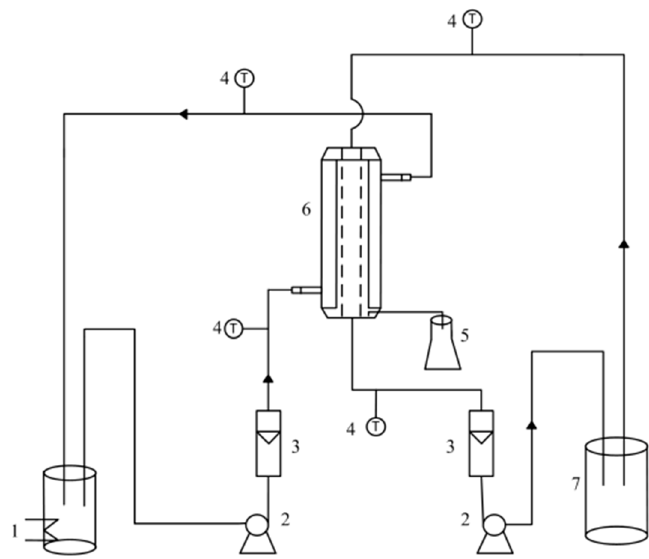
Figure 1. Experimental apparatus diagram of air gap membrane distillation system. ( 1 ) Thermostatic hot bath; ( 2 ) magnetic pump; ( 3 ) liquid flowmeter; ( 4 ) thermometer; ( 5 ) product water collector; ( 6 ) membrane module; ( 7 ) thermostatic cold bath.